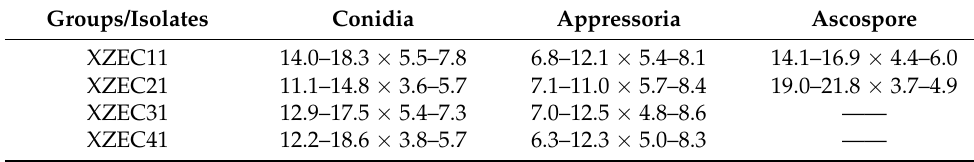
Table 2. The size of morphological structures of four Colletotrichum groups.